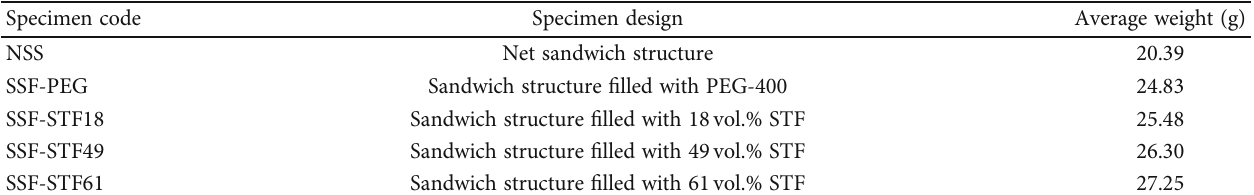
Figure 3: (a) Image of vibration test and (b) the schematic diagram of VBT set-up. Table 1: The experimental design of vibration